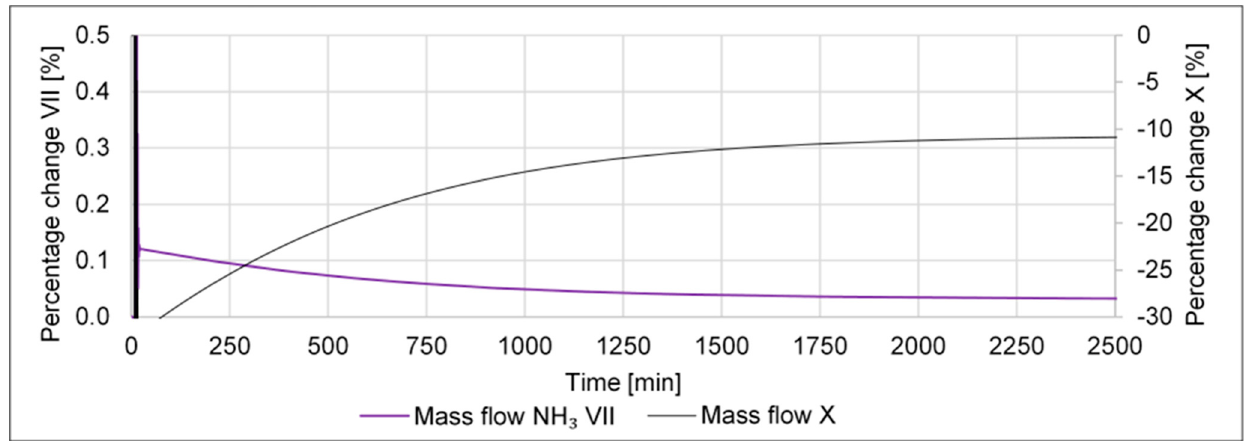
Figure 13 . Percentage change of mass fl ows NH3 VII and X (left and right vertical axis) of scenario Figure 13. Percentage change of mass flows NH3 VII and X (left and right vertical axis) of scenario (e).